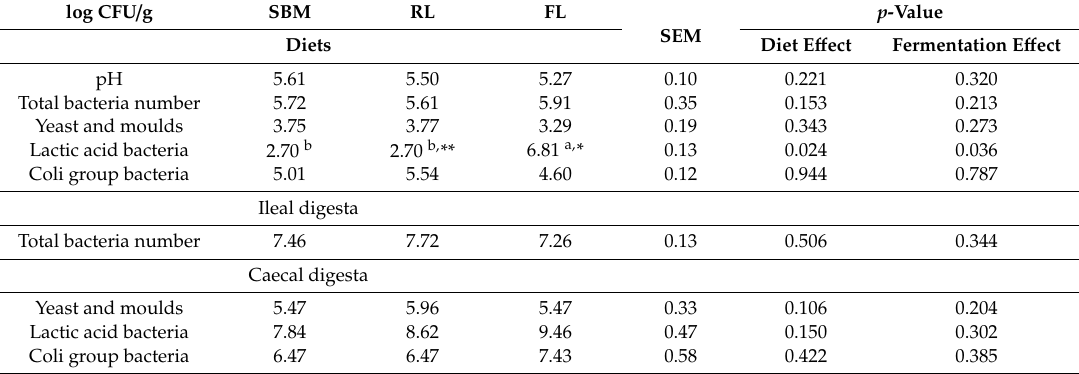
Table 6. Microbial composition of diets with soybean meal, raw and fermented lupine and ileal and cecal digesta, log CFU / g.